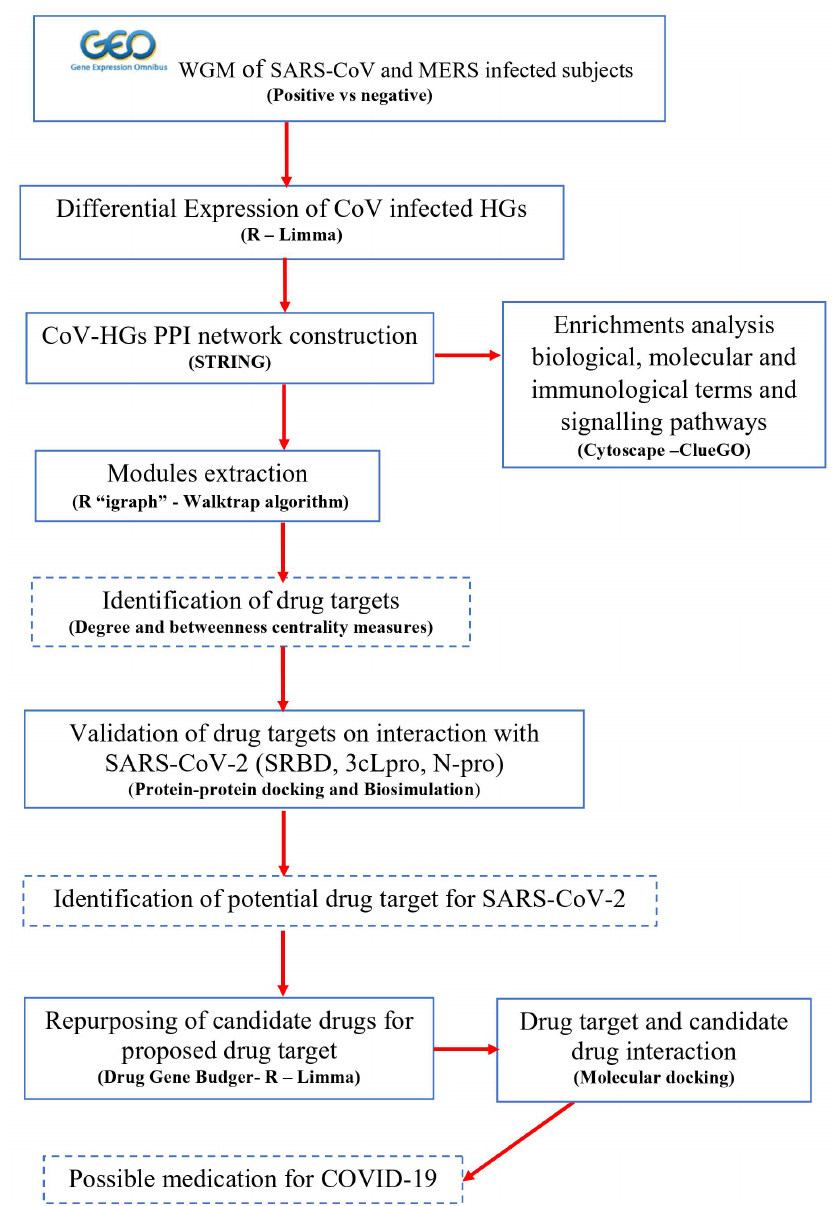
Figure 1. Schematic illustration of the study. WGM-whole genome microarray; SARS-CoV- ; MERS-; HGs-host genes; PPI-protein-protein interaction; SRBD-spike receptor binding domain; 3cLpro-3C-like protease; N pro-nucleocapsid protein;